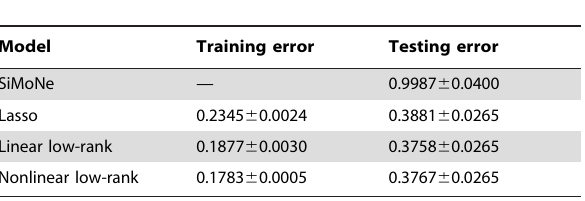
Table 2. Root-mean-squared error (RMSE) comparison among different models on the human hematopoietic gene expression data.